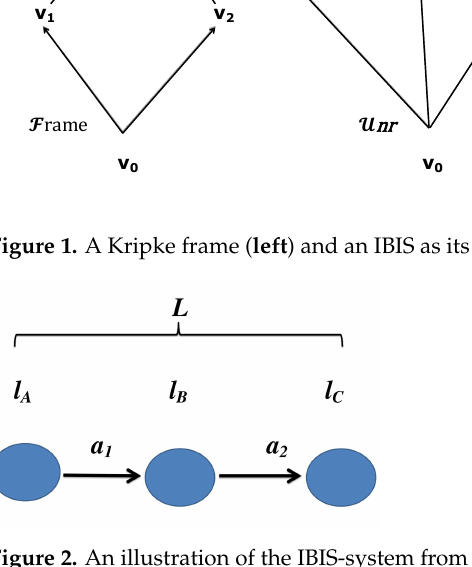
Figure 2. An illustration of the IBIS-system from the example